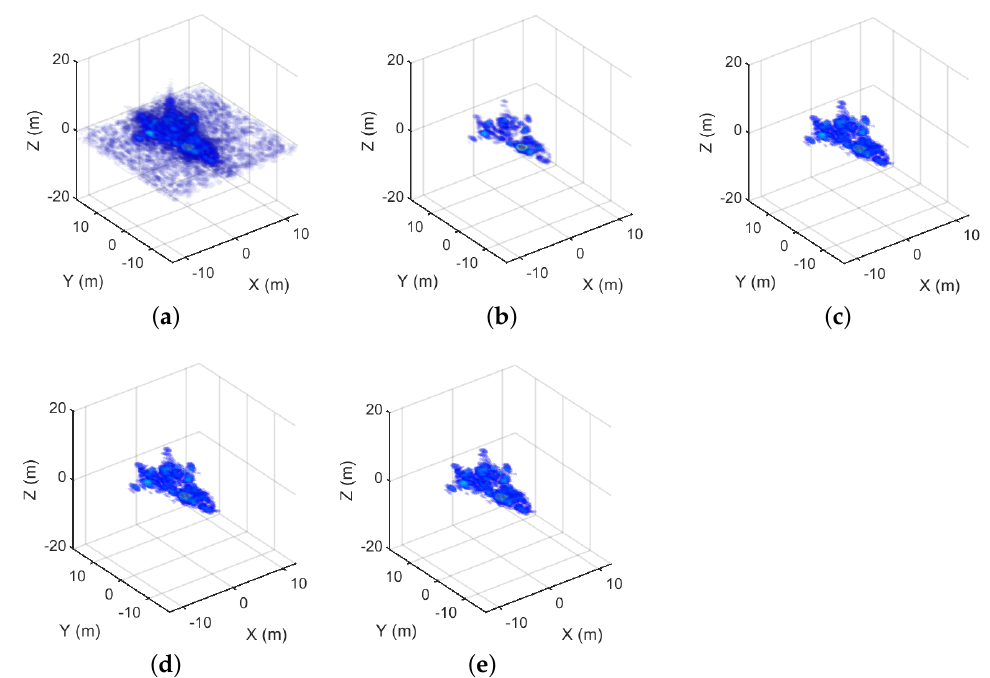
Figure 12. The imaging results of aircraft corresponding to the 50% sampling. ( a ) The MF result. ( b ) The FIST result. ( c ) The SCAD result. ( d ) The MCP result. ( e ) The GSALSA–Cauchy result.